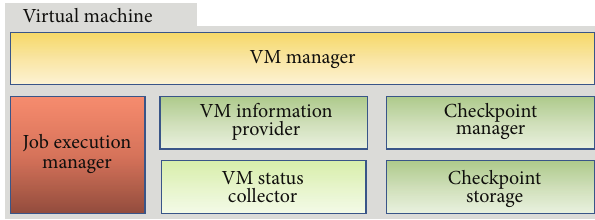
Figure 3: The structure of virtual